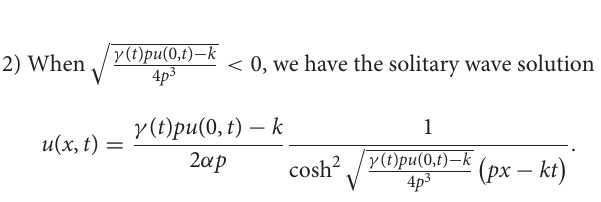
t 1, α 0.5, p 1, and γ ( t ) = = = − = −